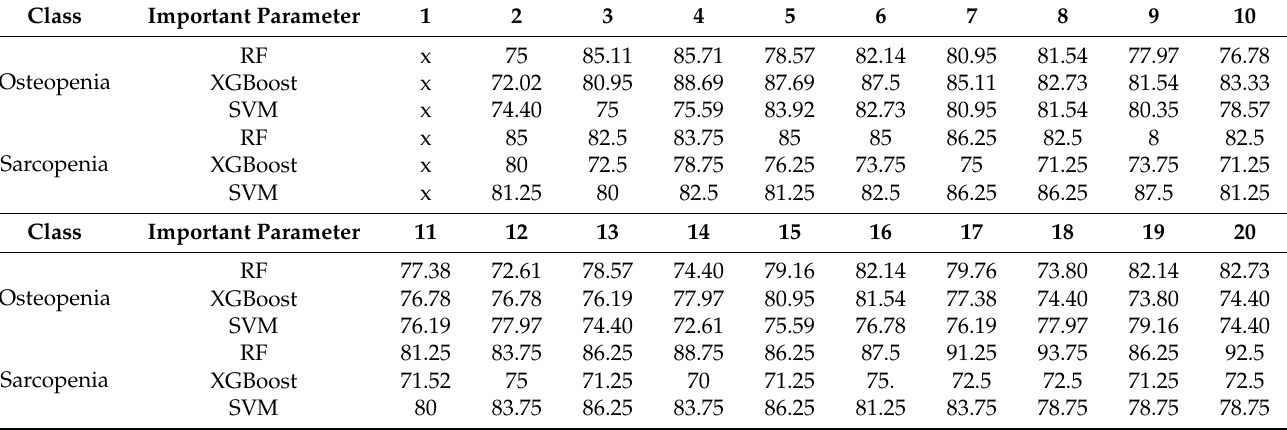
Table 11. Osteopenia and sarcopenia identification results with the 20 parameters from Table 9 (accuracy,